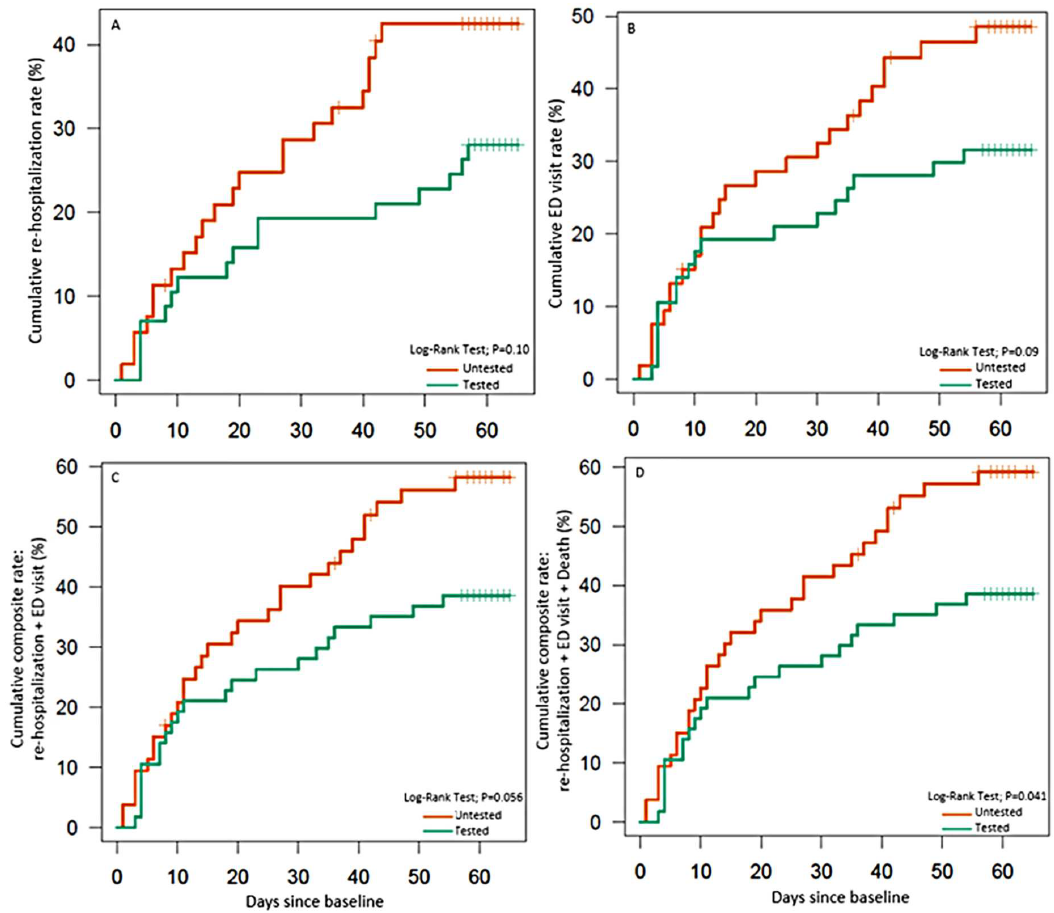
Fig 2. Cumulative rate (%) for re-hospitalizations, ED visits, and composite events using Kaplan-Meier estimator. 2A and 2B represent the Kaplan-Meier curves for the time to first re-hospitalization and to the first ED visits, respectively. 2C and 2D represent the Kaplan-Meier curves for the time-to-cumulativecomposite event outcomesfor re-hospitalizations + ED visits and re-hospitalizations + ED visits + deaths, respectively. ED, emergencydepartment; p, p value. The vertical lines on the survival curves show the times when event-free subjects reach the end of their protocol pre-specified follow-up of approximately 60 days